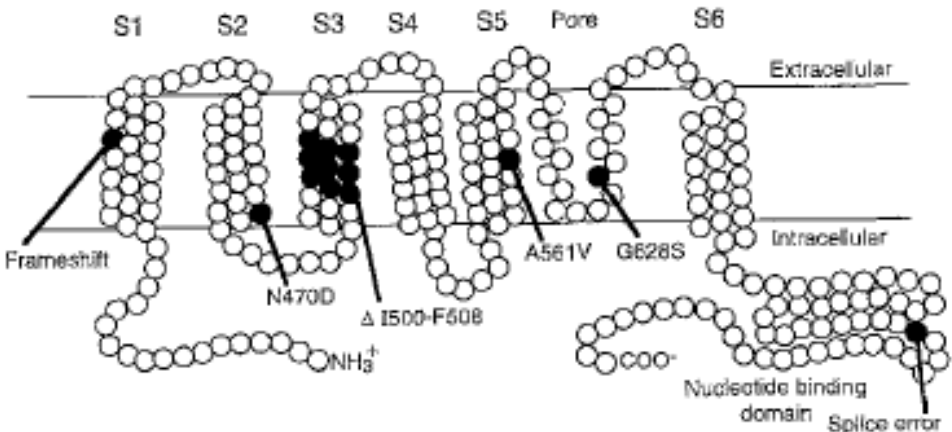
Figure 1. From reference [7], one of several illustrations from the series of scientific publications revealing the molecular knowledge on LQT mutations and ion channelopathies. Reproduced with permission from Elsevier Publisher.